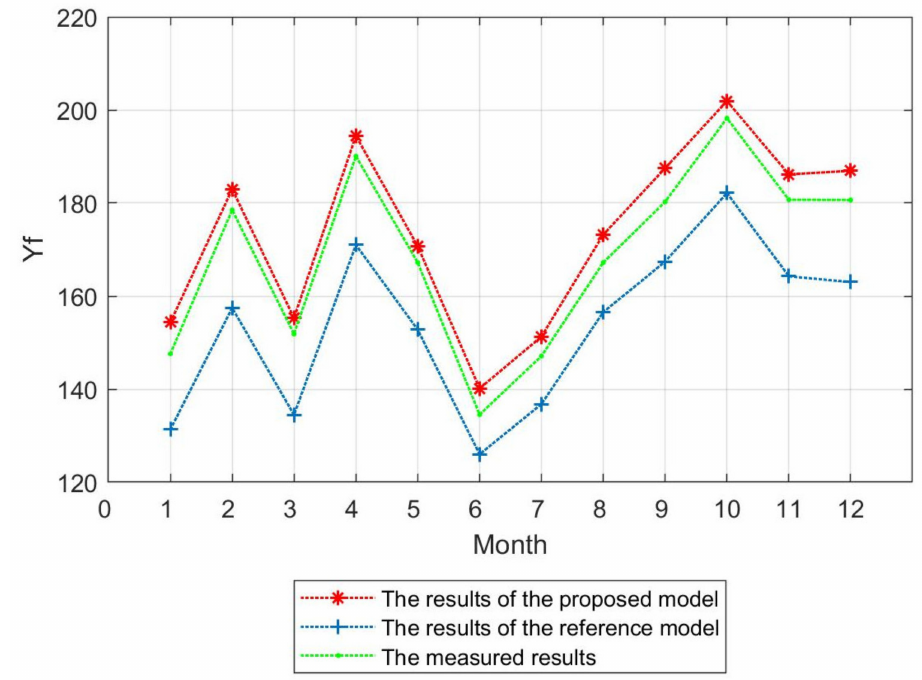
Figure 9. Monthly values of Y f .